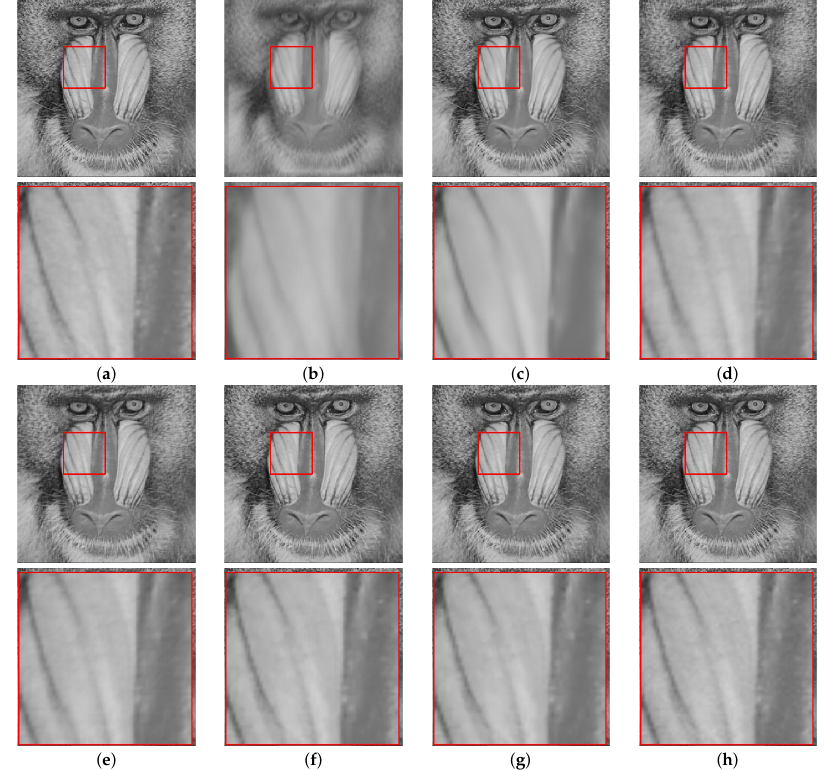
Figure 2. The Banoon image restored by all algorithms. ( a ) Banoon, ( b ) degraded, ( c ) IDBP, ( d ) D-